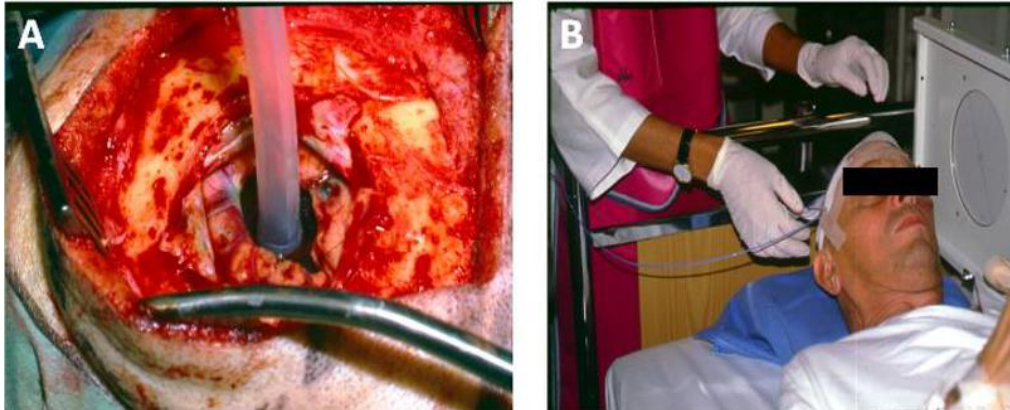
Figure 10. PDT treatment of a glioblastoma patient. ( A ) Implantation of an indwelling balloon catheter for use as a radiation or light applicator. After closure of the operative field the catheter is brought out through the skin and remains in place for several days. ( B ) A patient receiving after-loading brachytherapy [242]. The same applicator can be used for PCI.